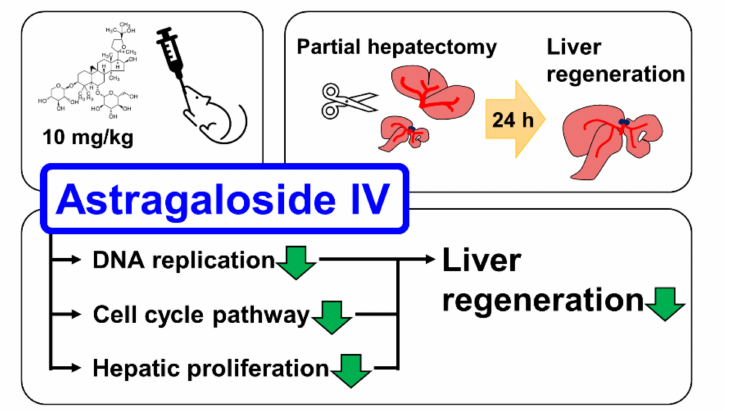
Figure 8. Graphical abstract of study. AS-IV suppressed hepatic proliferation of regenerating liver tissues after 70%